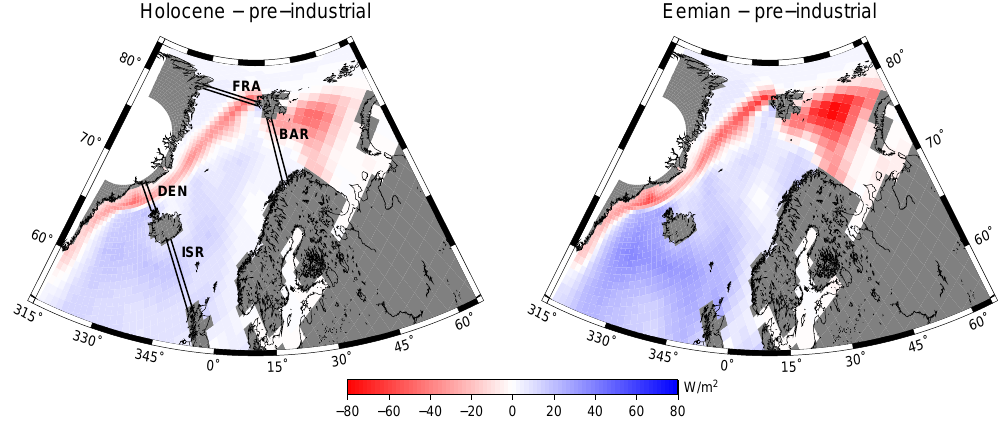
Fig. 8. Ocean-atmosphere heat flux differences in W/m 2 over the Nordic Seas and Barents Shelf. Increases in heat flux from the ocean to the atmosphere (negative sign) occur mainly in regions where sea ice cover is decreased, over the Barents Shelf and on the East coast of Greenland. South of Iceland and in the Eastern part of the Nordic Seas ocean-to-atmosphere heat flux is reduced. The black lines denote the passages used for the calculation of the heat transport in and out of the basin: ISR - Iceland-Scottland-Ridge, DEN - Denmark Strait, BAR - Barents Shelf, FRA - Fram Strait.